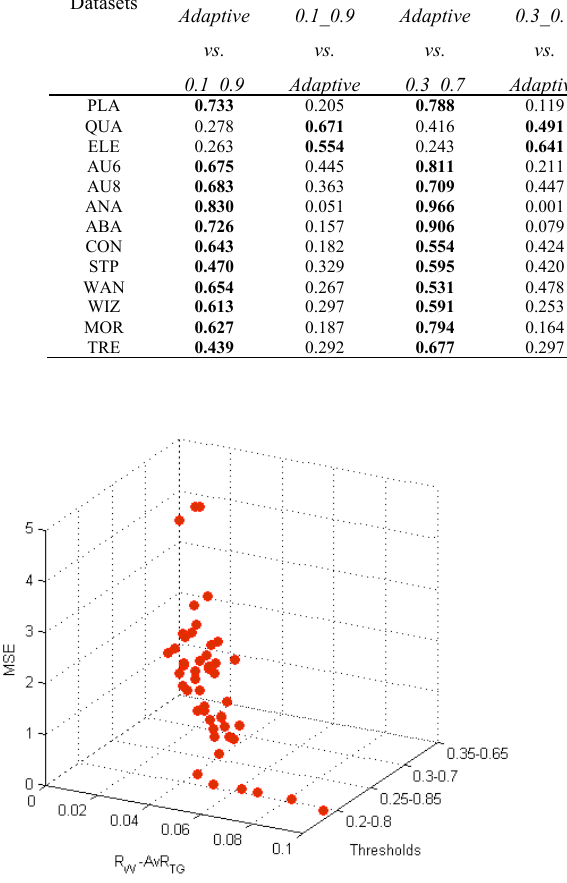
Fig. 6. Example of thresholds found by the adaptive width mechanism in MOR